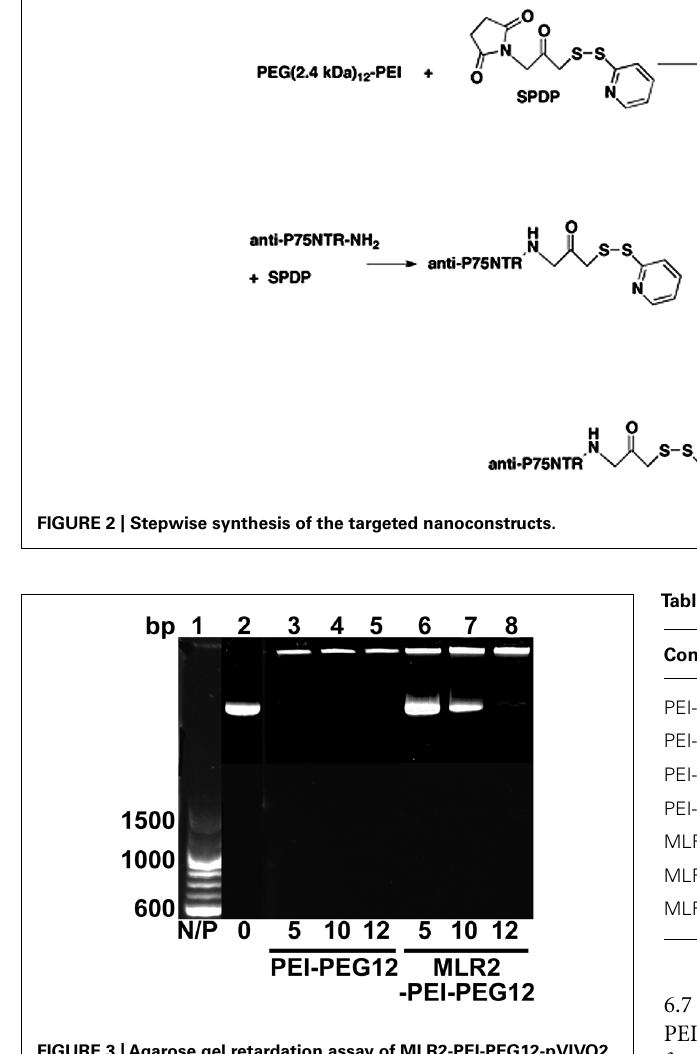
FIGURE 3 |Agarose gel retardation assay of MLR2-PEI-PEG12-pVIVO2 and PEI-PEG12-pVIVO2. Lane 1, 100 bp ladder; lane 2, naked pVIVO2 (400 ng); lane 3–5 400 ng pVIVO2 with PEI-PEG12 at N/P 5, 10, and 12; lanes 6–8 400 ng pVIVO2 with MLR2-PEI-PEG12 at N/P 5, 10, and 12.